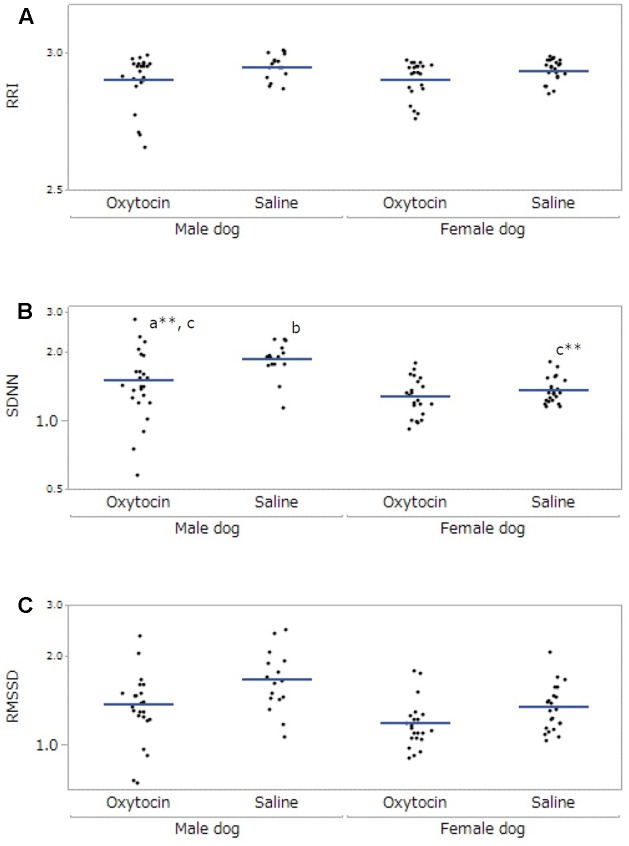
Comparisons of heart rate variability of owners between oxytocin and saline treatment conditions. All parameters, RRI (A), SDNN (B), and RMSSD (C), showed significant differences between oxytocin and saline treatments conditions. Significant dog-sex differences were observed in SDNN and RMSSD. A significant interaction between administration and dog’s sex was found in SDNN. Results are shown with logarithmic. The blue lines indicates the mean of HRV. ∗∗p < 0.001.